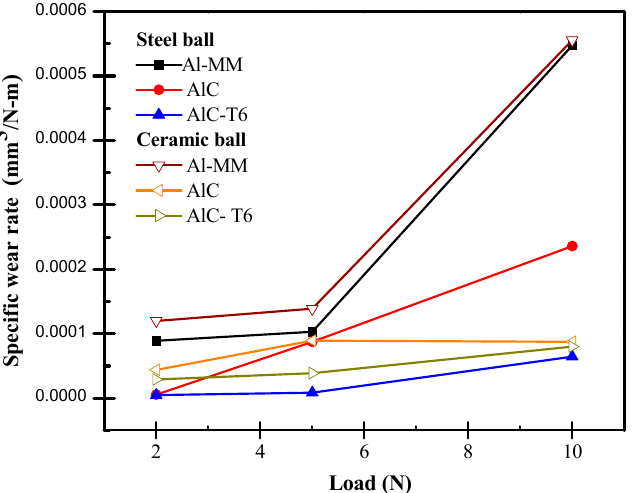
Figure 6. Variation in the wear rate with respect to the normal load applied in the tribological pairs of MM and AlC in contact with 52100 steel and α -alumina pin.